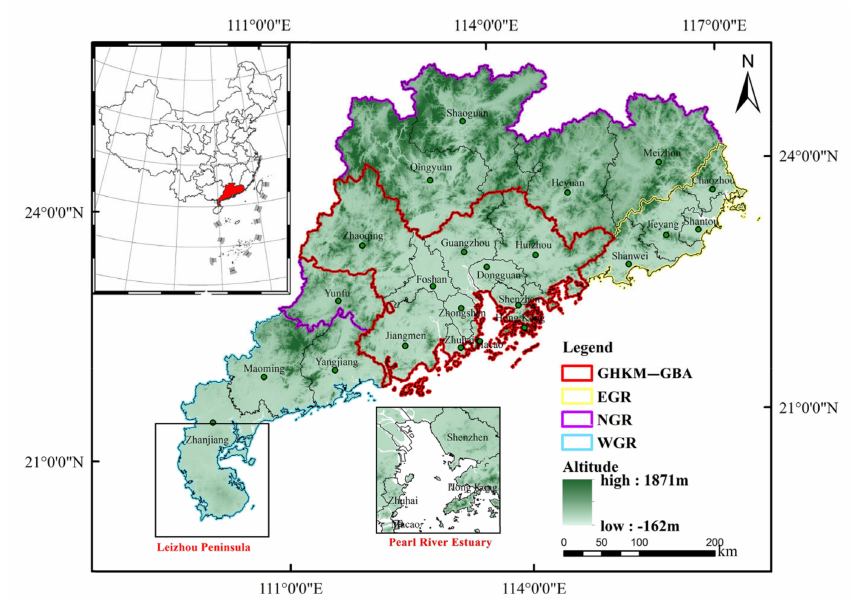
Figure 1. Location of the study area in China illustrating the four regions of the